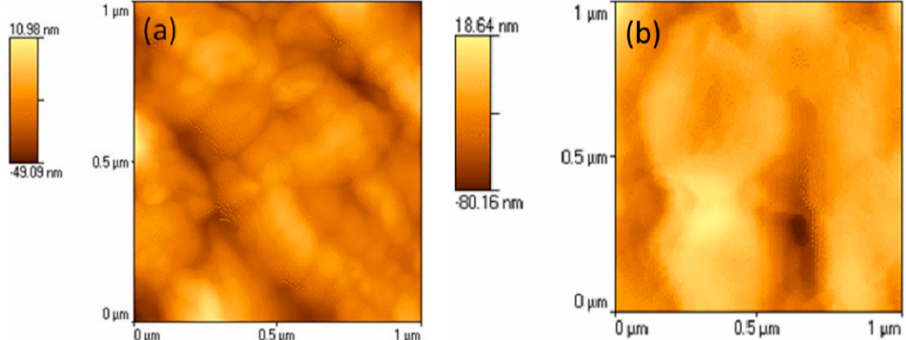
Figure 5. AFM images of ( a ) un-doped CdO and ( b ) Sn:CdO thin films.